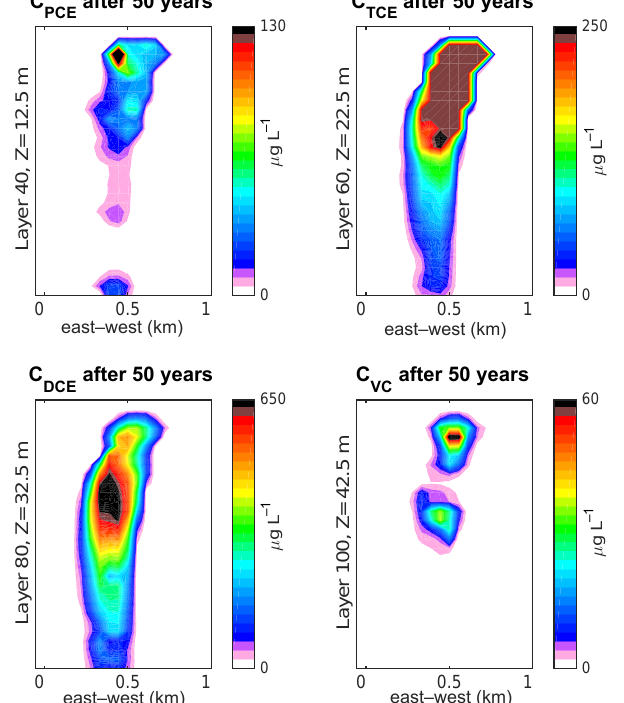
Figure 4. Contaminant plume after 50 years for PCE, TCE, DCE and VC in layers 40, 60, 80 and 100, respectively. Vertically, the contaminant plume tends to move downwards towards the Pleis- tocene clay layers and the second aquifer. In the lateral direction, displacement of the plume occurs southwards.